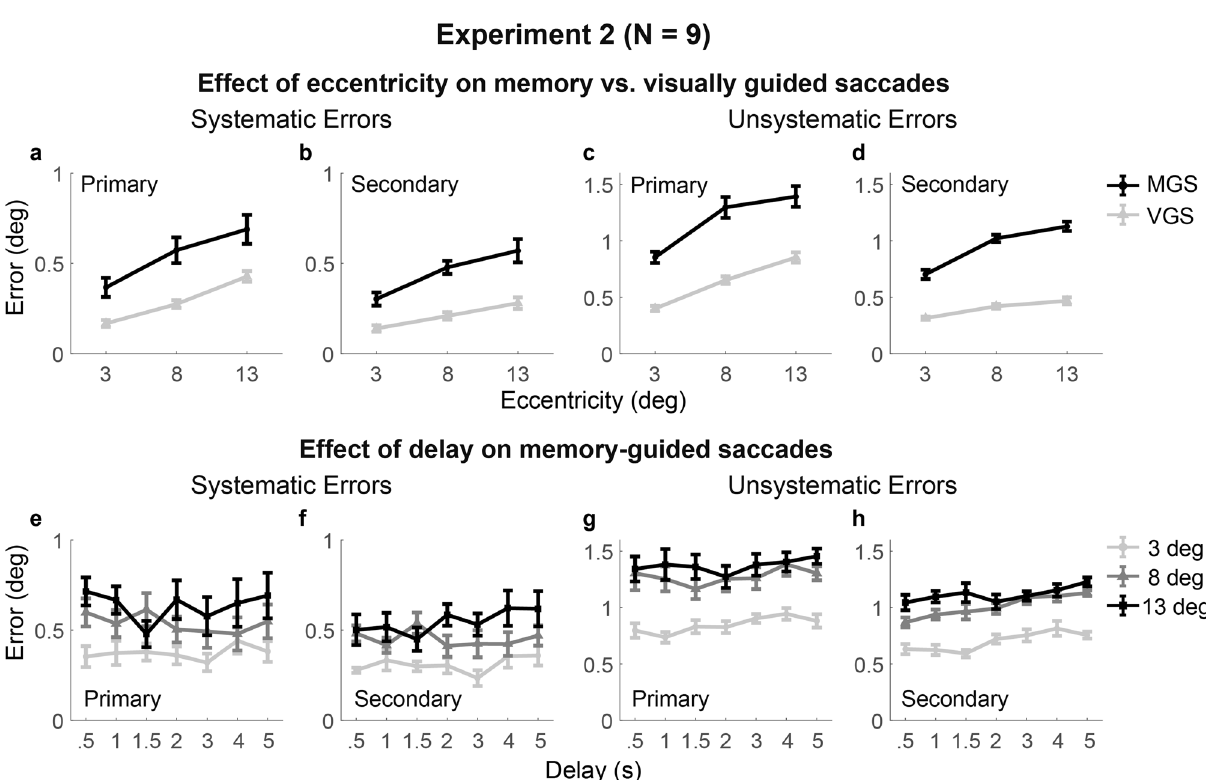
Figure 5. Saccade endpoint errors across tasks, eccentricities, and delays in Experiment 2. See notations in Fig. 4. Systematic and unsystematic errors increased with increasing eccentricity, with a greater linear and quadratic increase in the unsystematic errors in the MGS than the VGS. Unsystematic errors in the MGS accumulated from the 0.5-s to 5-s delay intervals significantly for the secondary saccades and were trending significance for the primary saccades in a similar pattern across